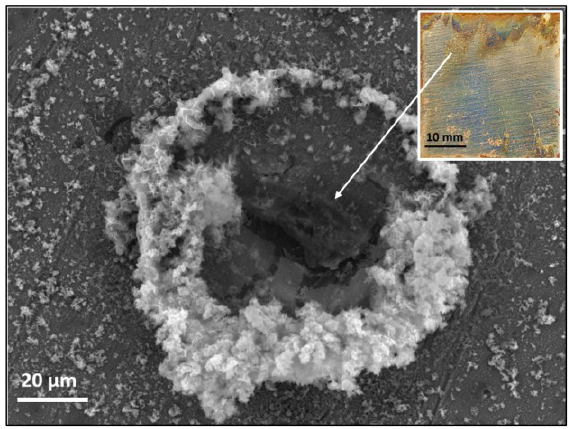
Figure 9. Secondary electron SEM image showing corrosion attack morphology of the ground mild steel sample immersed in 3.5 wt. % NaCl solution at the instant measurement time. The inset figure demonstrates the uniform corrosion pattern and rust formation on the